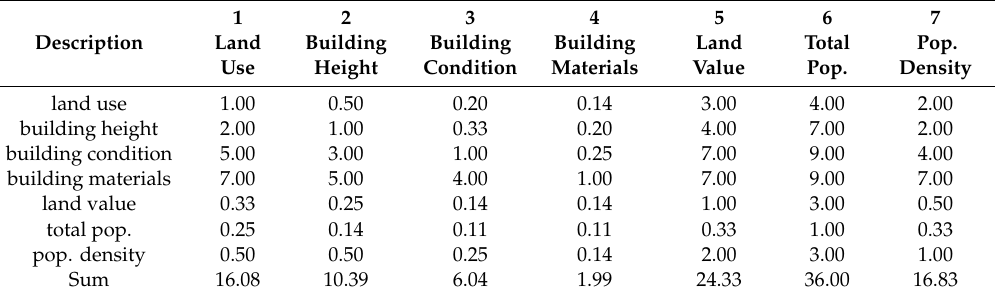
Table A2. Pairwise comparisons